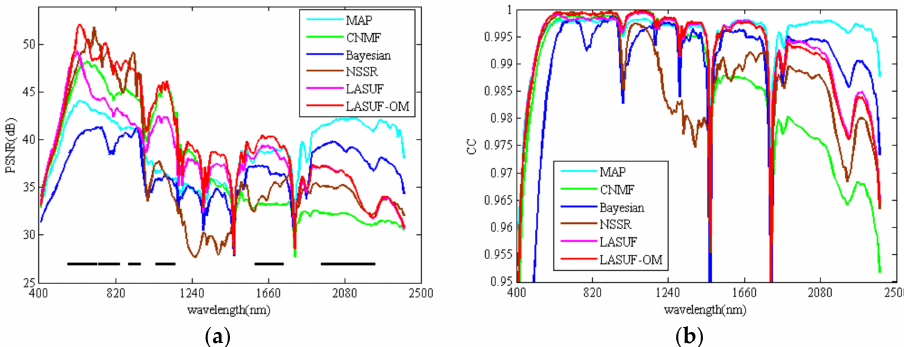
Figure 8. Comparisons of individual bands for Washington D.C.: ( a ) PSNR; ( b ) CC.